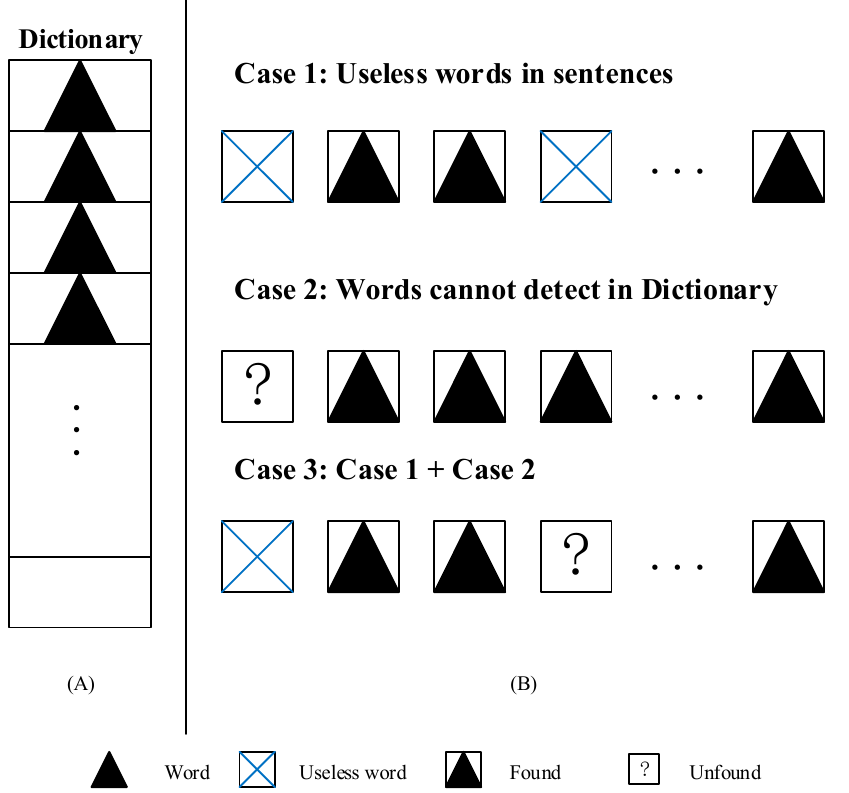
Figure 3. An incomplete dictionary with three hidden situations. ( A ) An incomplete dictionary. ( B ) Three hidden